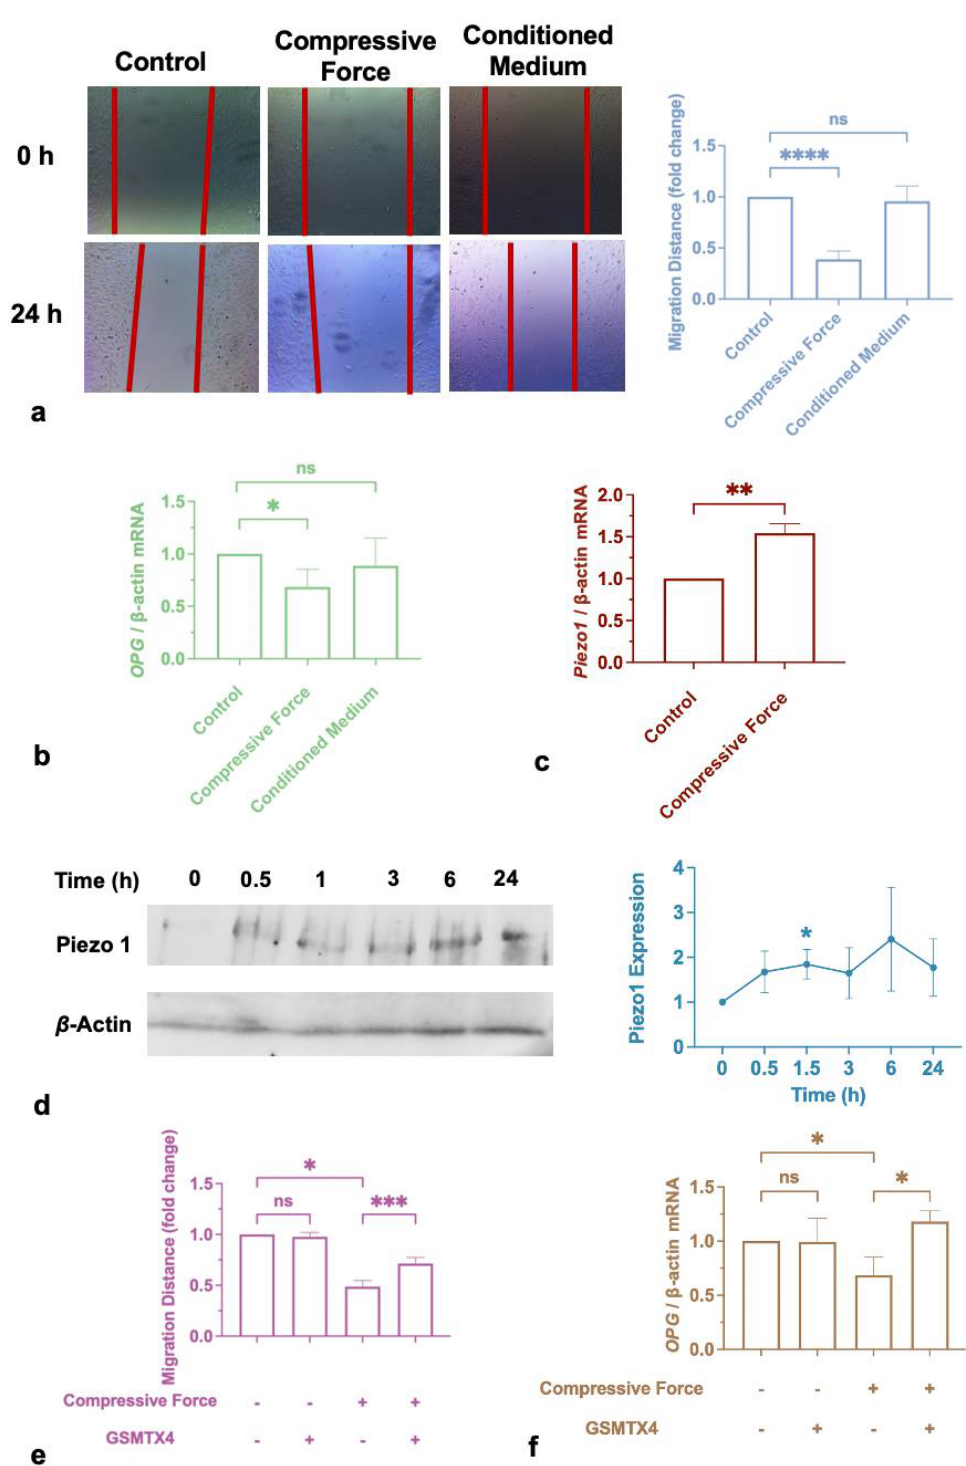
Figure 5. Compression impaired cementoblastic function. ( a ) Migration distance decreased after force-loading in 24 h but did not alter after incubation with conditioned medium. ( b ) qRT-PCR results demonstrate that OPG was repressed by compressive force in 24 h. ( c , d ) Compressive force triggered cementoblasts to express Piezo1 at the gene and protein levels. ( e ) Piezo1 inhibitor blunted migration impairment induced by compression. ( f ) Piezo1 inhibitor rescued OPG expression in the presence of compression. Values are expressed as sign means ± SD; ns — not significant; * p < 0.05, ** p < 0.01 ; *** p < 0.001; **** p < 0.001.